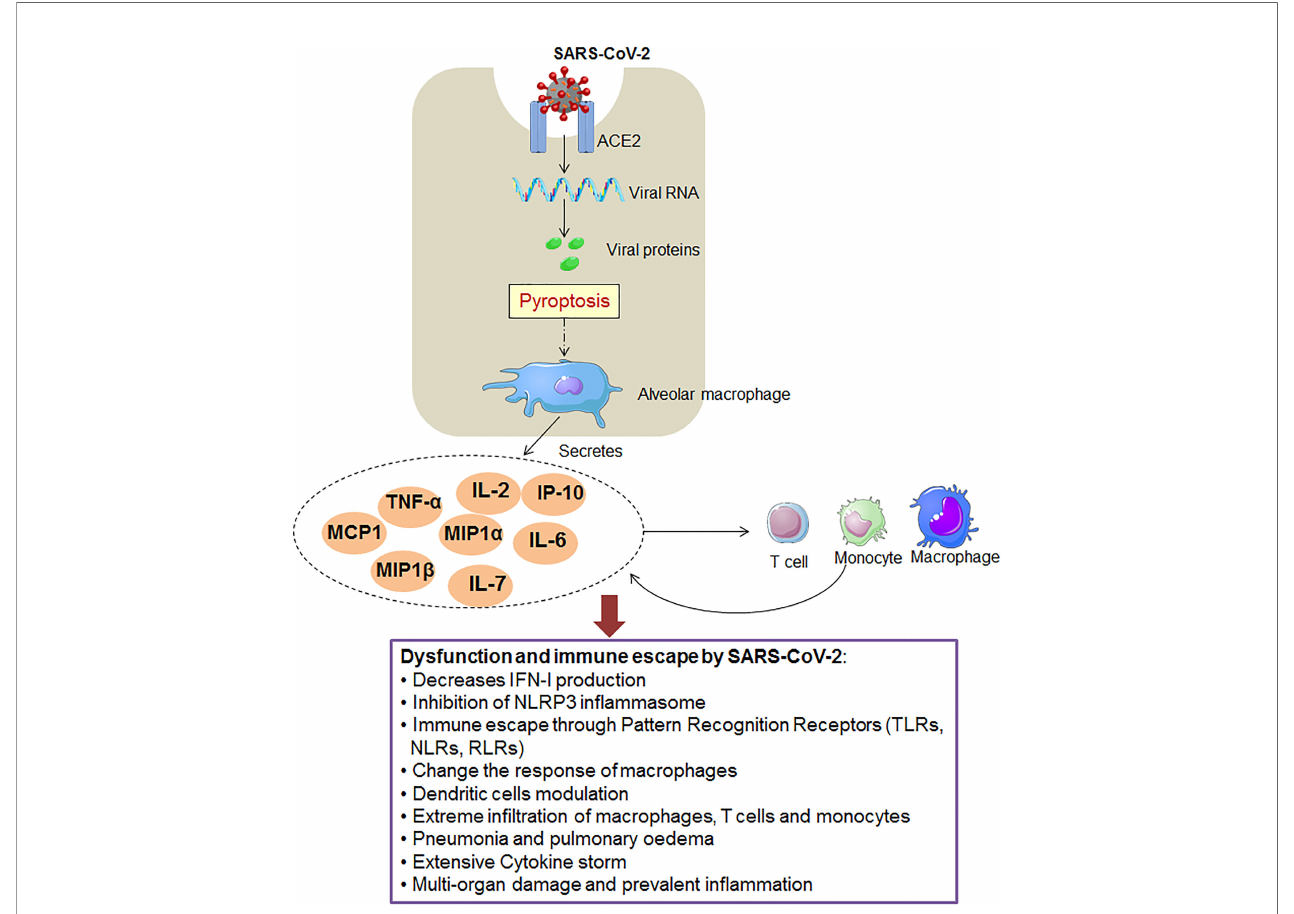
FIGURE 1 | The fi gure shows the SARS-CoV-2 that adopts different innate immunity evasion strategies for immunity